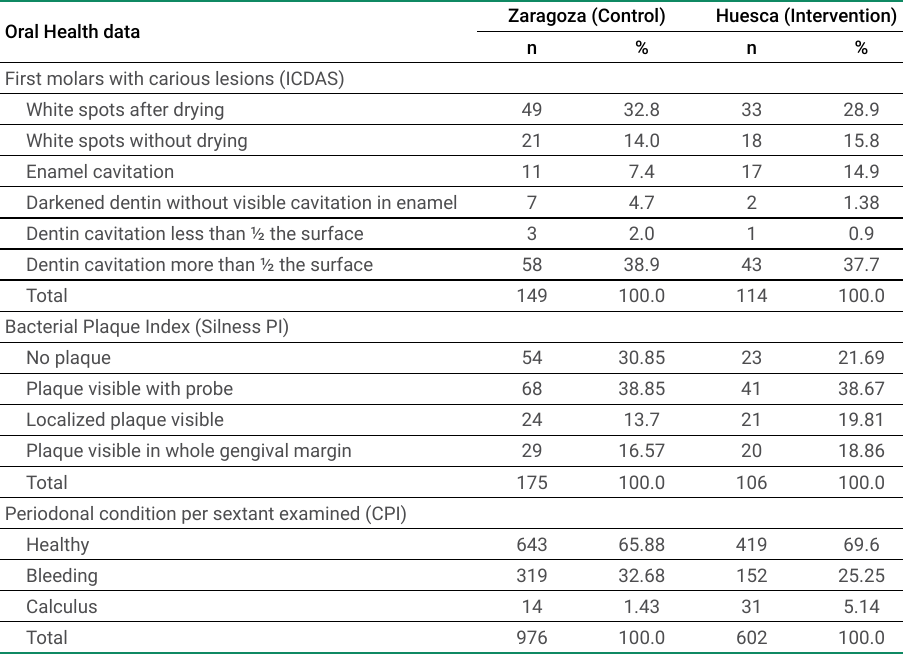
Table 2. Oral health data for 7 to 11-year-olds per city, at T3, in terms of the I.FAMILY study, Spain, 2013 Oral Health data